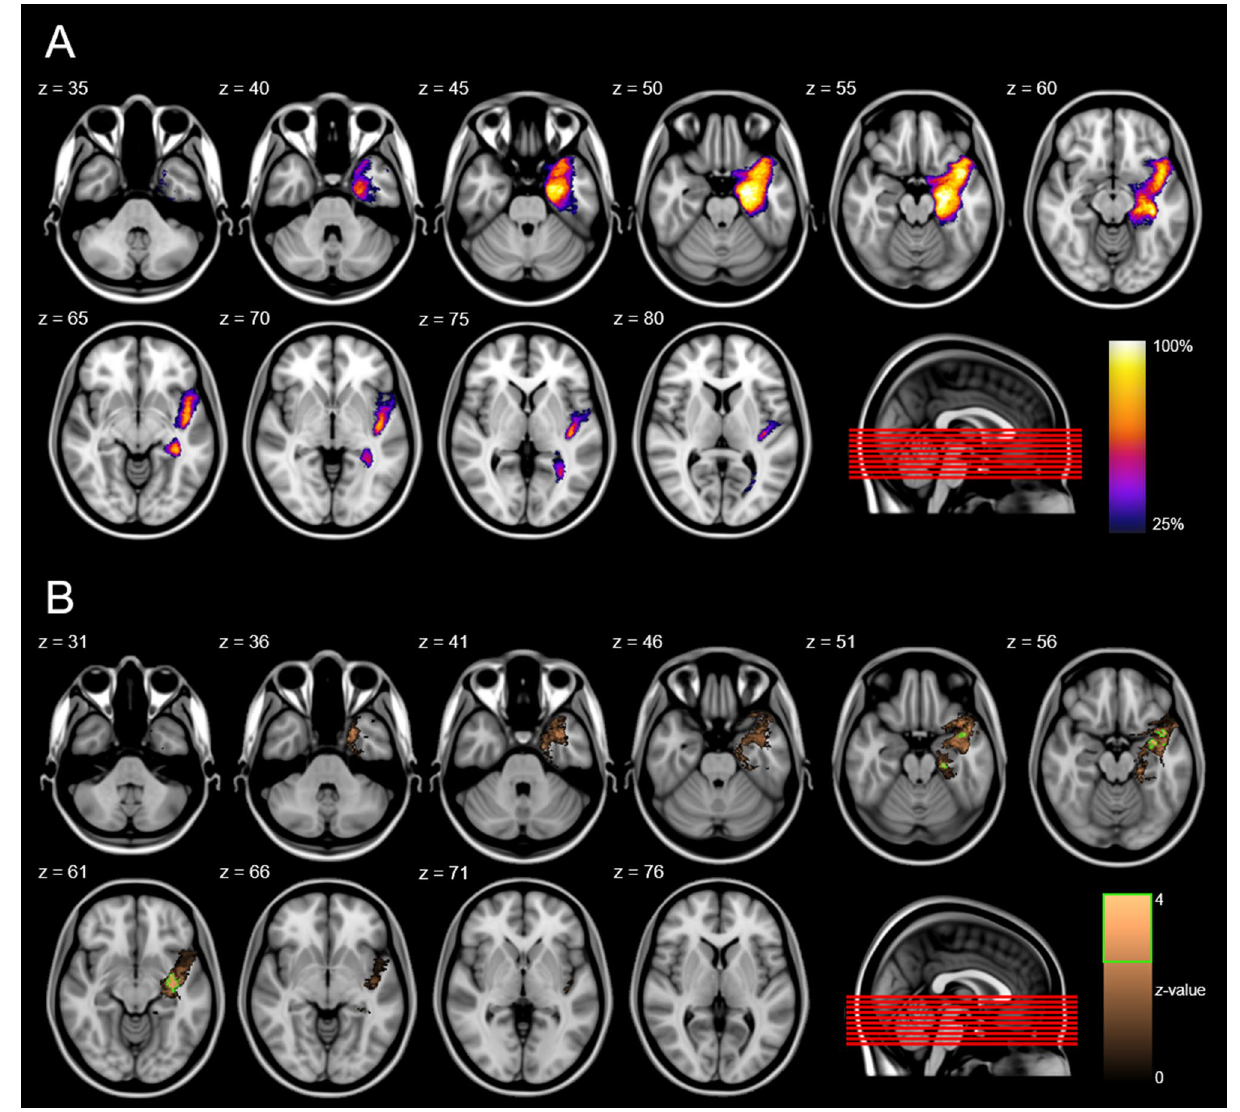
Figure 1. Canonical lesion mask and voxel-based lesion symptom mapping. ( A ) Canonical lesion mask after non-linear registration of all patients showing the overall lesion extent. ( B ) VLSM analysis showing a significant association between lesioned voxels and postsurgical VFDs (FWE-corr. p < 0.05). Green outlines indicate clusters reaching significance. z indicates axial level in MNI patient group. The opposite contrast as well as the correlation analysis on presurgical DTI scans did not yield any significant results. Connectivity differences between groups. Comparing pre- and postsurgical mean connectivity matri- ces, sAH can be appreciated in the zeroed postsurgical connections including amygdala and hippocampus (see Supplementary Fig. S1). Apart from this obvious observation, a slight overall drop in streamline count of con- nections within the ipsilesional hemisphere (upper left quadrant of connectivity matrices) in both the VFD and no VFD patient group can be seen. However, sole visualization of the connectivity matrices does not yield obvi- ous differences between the two patient groups. Using permutation-based paired t -tests between pre- and postsurgical scans, a decrease in streamline count of four edges including six nodes within the ipsilesional hemisphere was found in patients showing no VFD after sAH (FWE-corr. p < 0.05, see Fig. 4A). In contrast to that, patients with postsurgical VFD showed an extensive loss of connectivity in a total of 73 edges involving 28 different brain regions (FWE-corr. p < 0.05; see Tables S1 and S2 for a list of all affected edges). Affected edges covered most of the ipsilesional temporal lobe, subcortical and prefrontal areas as well as temporo-occipital connections. Additionally, three brain regions from the contral- esional hemisphere were included, namely the superior temporal gyrus, superior frontal gyrus, and pericalcarine cortex. No significantly increased streamline counts were found in the opposite contrast.